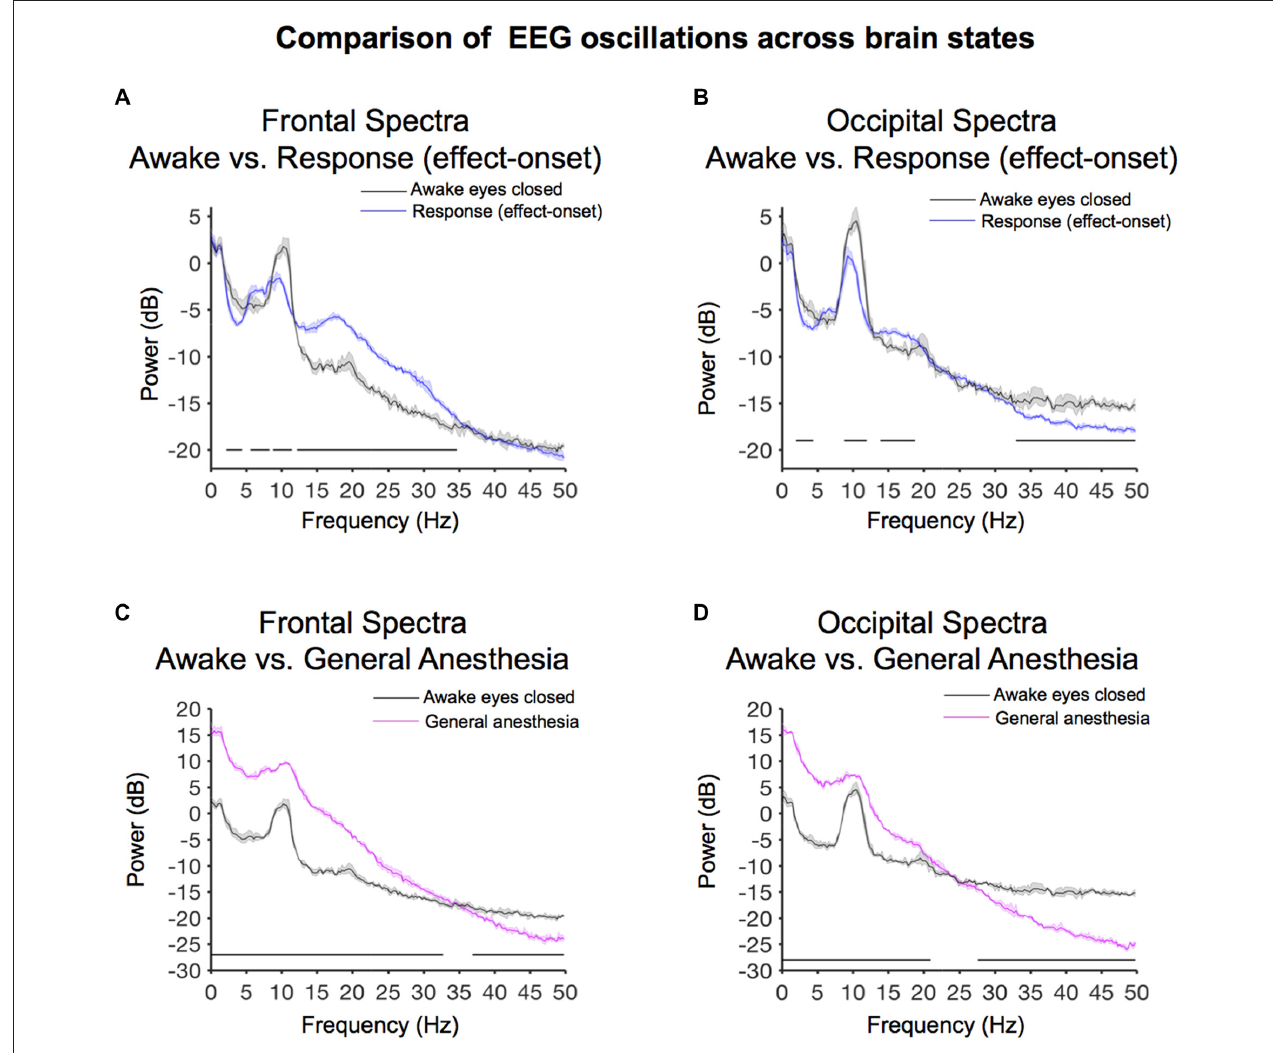
FIGURE 5 | Spectral comparison of baseline-awake vs. altered brain states. (A) Overlay of median baseline-awake frontal spectrum (black), and median effect-onset (response) frontal spectrum (blue). Bootstrapped median spectra are presented and the shaded regions represent the 99% confidence interval for the uncertainty around each median spectrum. We observed differences in power among frequency bands ( Table 1 ). Black lines represent statistically significant frequencies. (B) Overlay of median baseline-awake occipital spectrum (black), and median effect-onset (response) occipital spectrum (blue), with shaded regions depicting the 99% confidence interval for uncertainty around each bootstrapped median spectrum. We observed differences in power among frequency bands ( Table 1 ). Black lines represent statistically significant frequencies. (C) Overlay of median baseline-awake frontal spectrum (black), and median general anesthesia frontal spectrum (magenta). Bootstrapped median spectra are presented and the shaded regions represent the 99% confidence interval for the uncertainty around each median spectrum. We observed differences in power among frequency bands ( Table 1 ). Black lines represent statistically significant frequencies. (D) Overlay of median baseline-awake occipital spectrum (green), and median GA occipital spectrum (pink), with shaded regions depicting the 99% confidence interval of uncertainty around each bootstrapped median spectrum. We found differences in power between baseline-awake and effect-onset (response) frequency bands, as well as between baseline-awake and GA frequency bands (frontal response > baseline-awake: 5.9–8.3 Hz, 12.2–36.4 Hz; frontal response < baseline-awake: 2–4.2 Hz, 8.8–11.5 Hz; occipital response > baseline-awake: 14.4–18.3 Hz; occipital response < baseline-awake: 2–5.1 Hz, 8.5–11.2 Hz, 28.3–32.5 Hz, 35.2–49.8 Hz; frontal GA > baseline-awake: 0.1–31.5 Hz; frontal GA < baseline-awake: 37.6–49.8 Hz; occipital GA > baseline-awake: 0.1–19.8 Hz; occipital GA < baseline-awake: 24.9–49.8